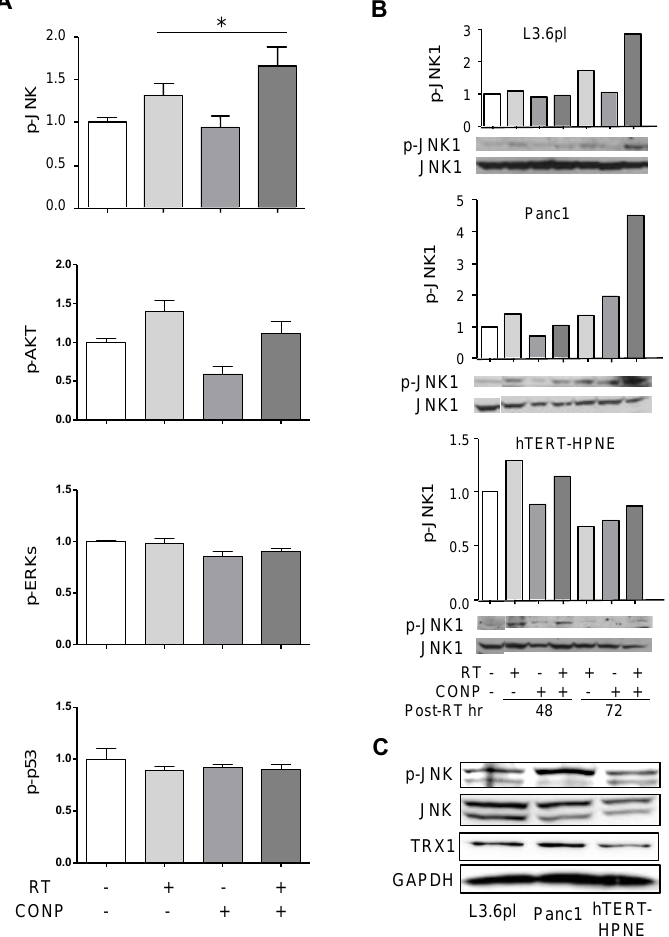
Figure 2. CONP Pre-Treatment Drives RT-Induced JNK Activation in Pancreatic Cancer Cells. ( A ) CONP treatment led to activation of JNK, but not AKT, ERKs or p53 in L3.6pl cells. Cells were treated with 10 µ M CONPs for 24 h followed by exposure to 0 or 5 Gy RT and allowed for 72 h prior to PhosphoELISAarray analysis. Levels were normalized to untreated group. * p < 0.05. ( B ) Indicated cells were treated similarly for the period of time indicated and subject to p-JNK1 analysis by Western blot (See Figure S1 for similar change in p-JNK2 levels). ( C ) Basal expression of pJNK, JNK, and TRX was determined in the cells by western blot, with cancer cells displaying higher levels of all three proteins.